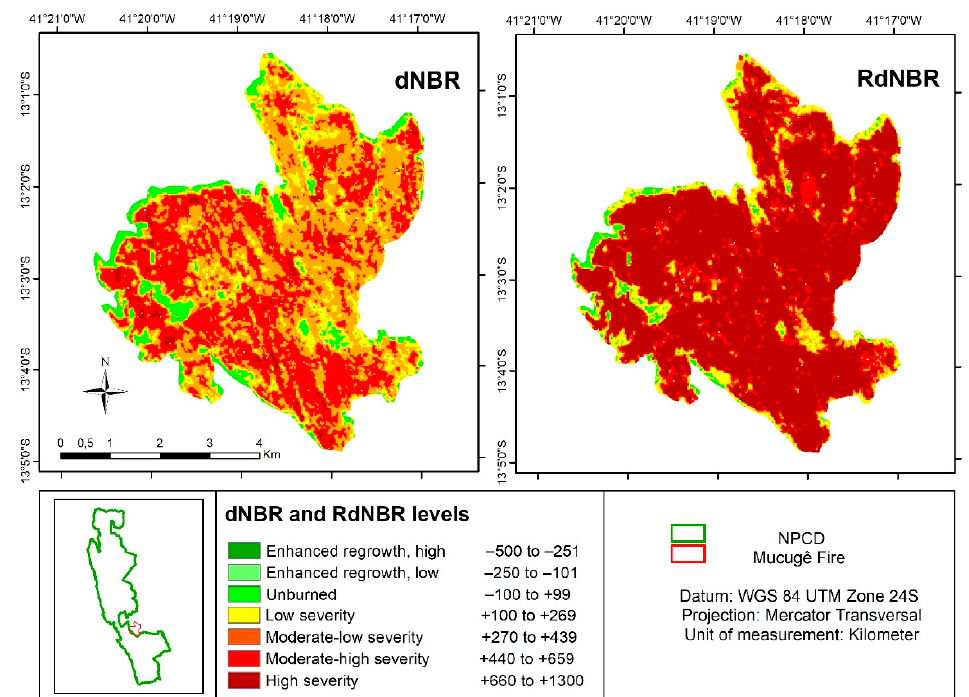
Figure 10. The severity of the fire identified by the dNBR and RdNBR indices relating to the fire near Mucugê (classification by Key and Benson [10]).